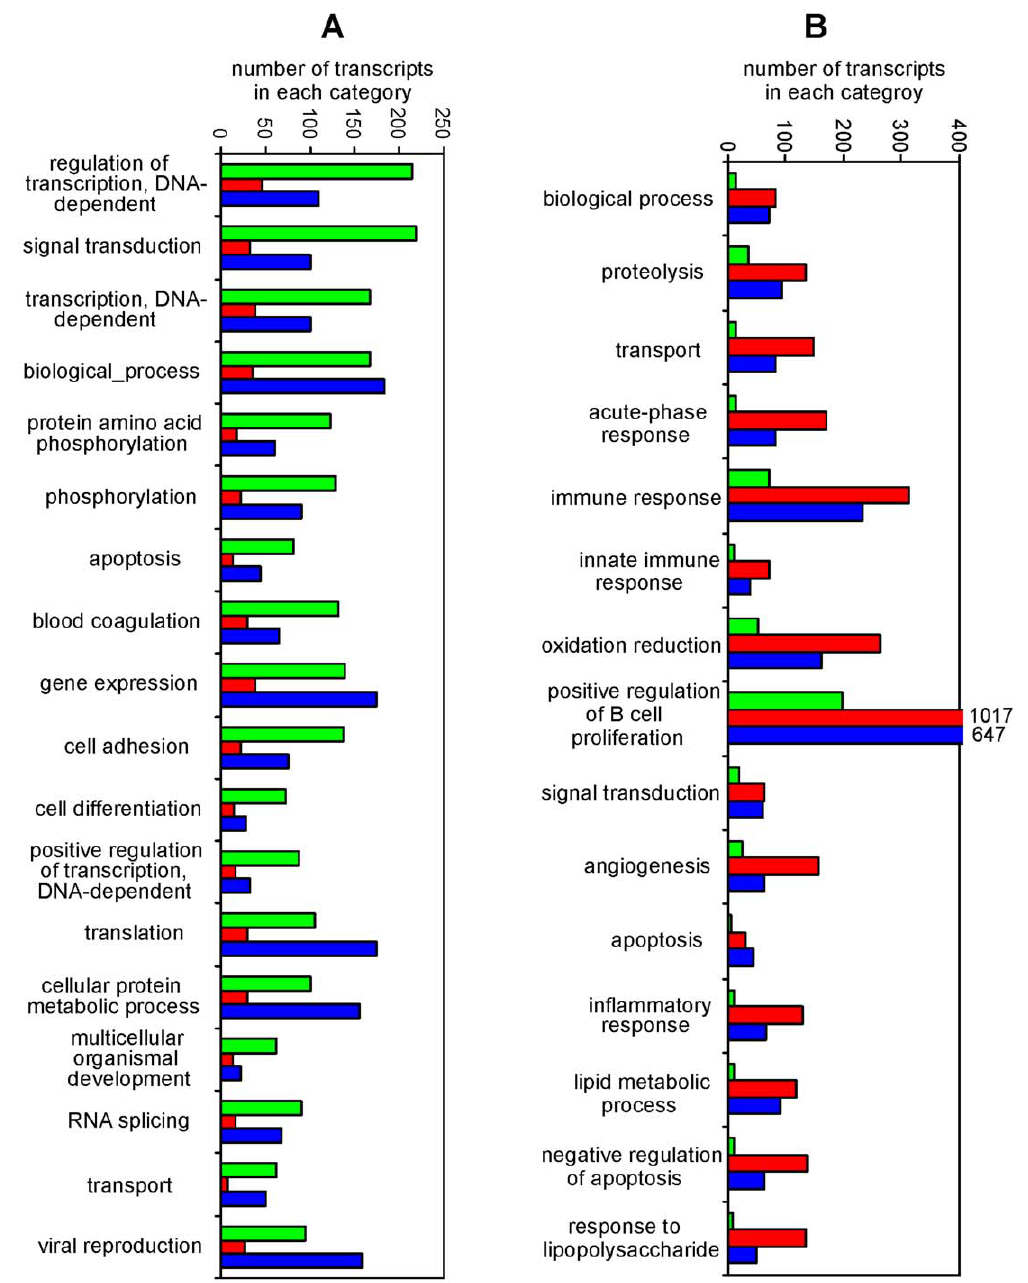
Figure 1. Cellular processes suppressed or induced in the spleen after S . Enteritidis infection. Green columns – expression in the spleen of non-infected chickens, red – expression in the spleen of infected chickens, blue – expression in the spleen of vaccinated and infected chickens. Number of transcripts for ‘‘positive regulation of B-cell proliferation’’ exceeding the Y-axis scaling is shown numerically. Panel A, suppressed Cellular processes, Panel B induced cellular processes.